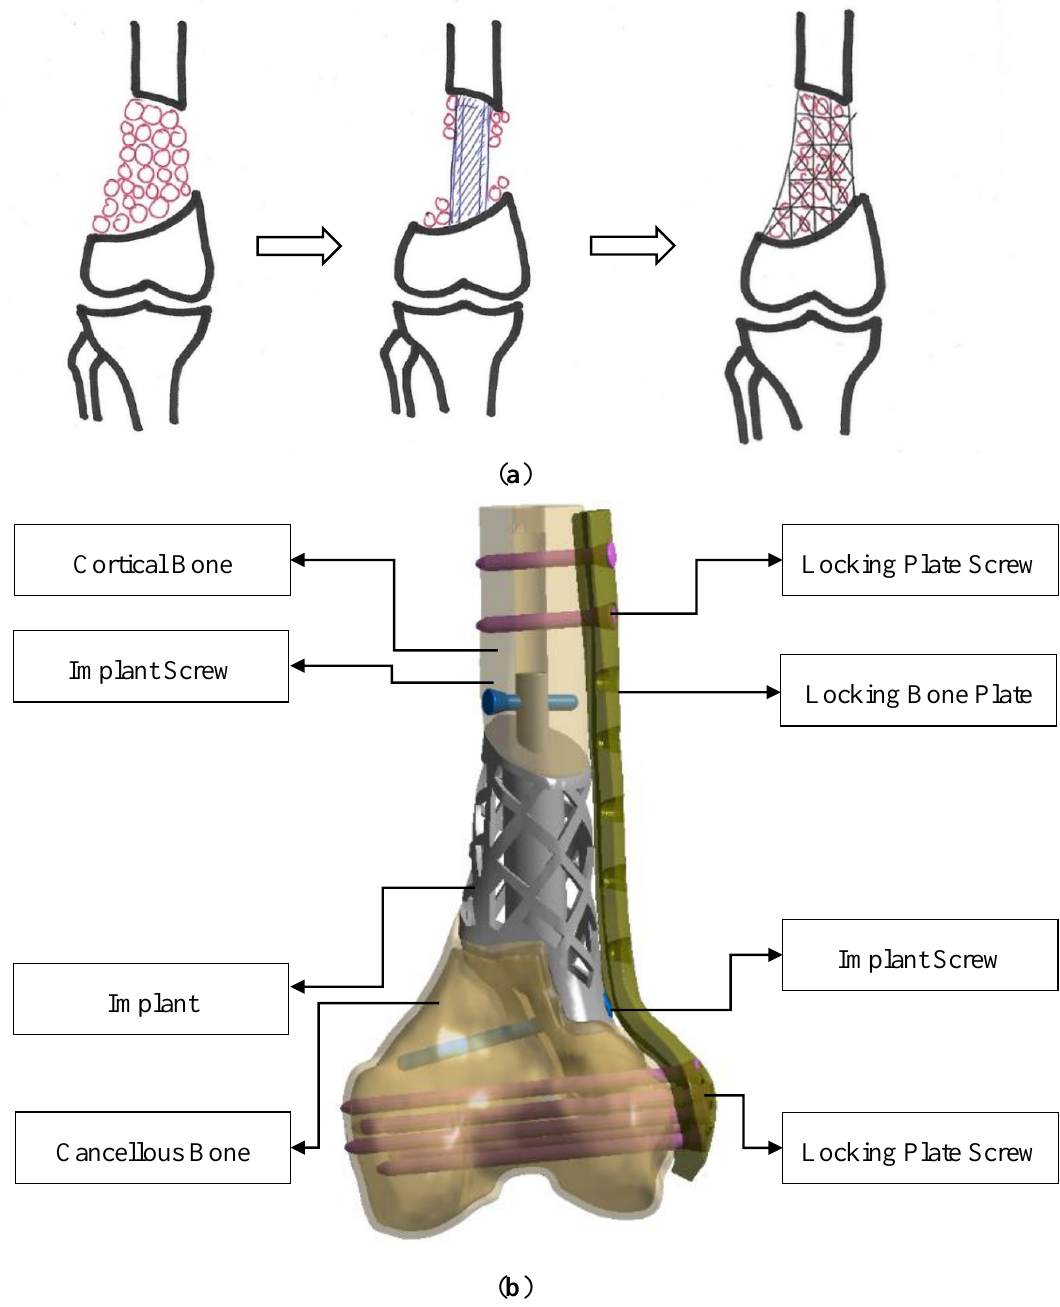
Figure 2. ( a ) Traditional surgical reconstruction methods using morselized bone graft (red circle) alone and strut graft (blue cylinder) with morselized bone graft. This novel implant perfectly matches the fracture site and fills up the defect. Bone graft can be protected within the implant. ( b ) Illustration model of the construct. The patient specific 3D printing titanium implant fit into the bone defect and fixed with host bone with implant screws. Additional lateral site pre-contoured locking plate was applied to secure the construct.